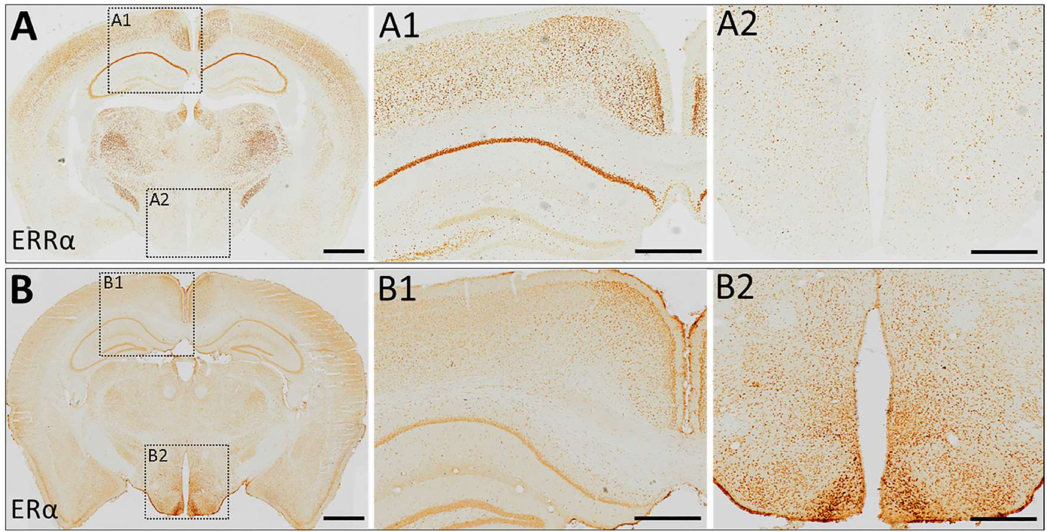
Figure 2. Representative immunohistochemistry (IHC) images showing ERR α ( A ) and ER α ( B ) expression in the mouse brain. Digital zooms of individual boxed regions are shown in A1, A2, B1, and B2. Note that expression pattern of ERR α and ER α is similar in the cortex and the hippocampus ( A1 , B1 ), but strikingly different expression was observed in the mediobasal hypothalamus ( A2 , B2 ) that is critical for the homeostatic regulation of energy balance. Note: the IHC image shown in ( A ) was from our previous publication with a zoom-in view [81]. The IHC image shown in ( B ) was from the brain sections of an adult female wild-type mouse stained with validated commercially available ER α antibody (1:1000, Millipore) as reported previously [71]. This ER α antibody was validated in conditional ER α KO mice previously [68]. Scale bar = 1 mm in A and B, and 500 µ m in A1, A2, B1, and